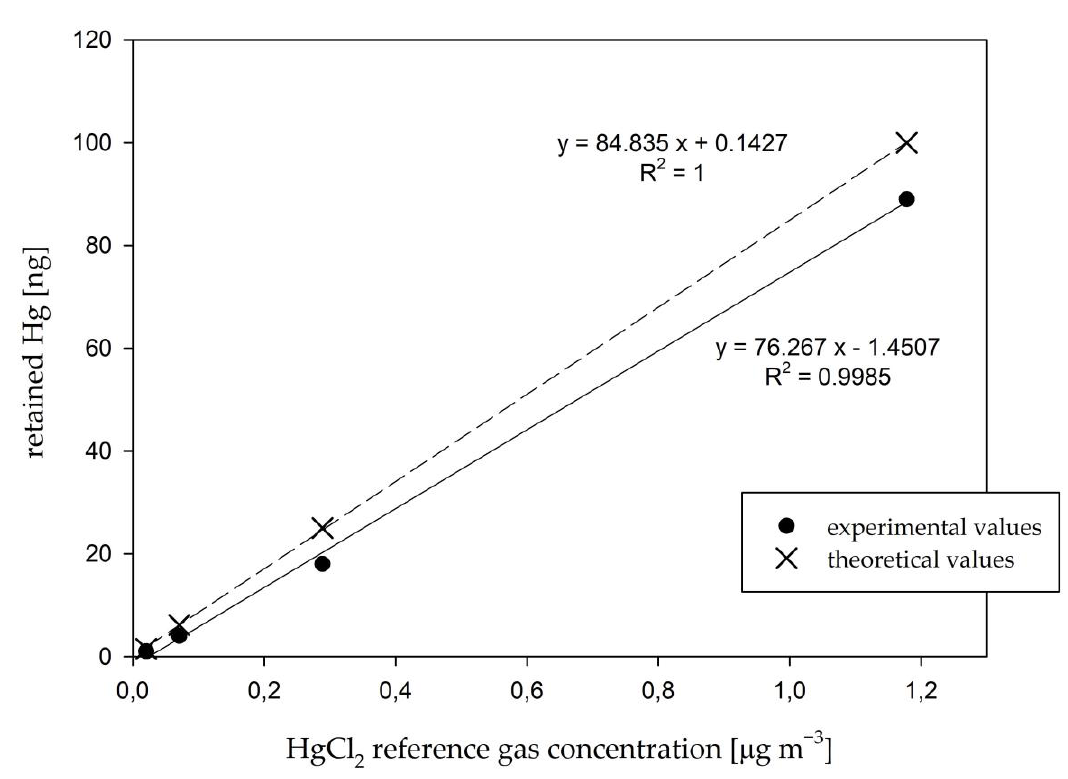
Figure 5. The linearity of the calibrator response at different HgCl 2 gas concentrations (from 5.90 to 1178 ng m − 3 ). Each data point represents a measurement at time 2 h after the calibrator start-up for four different HgCl 2 gas concentrations. Comparison is shown for theoretical and experimentally determined response.